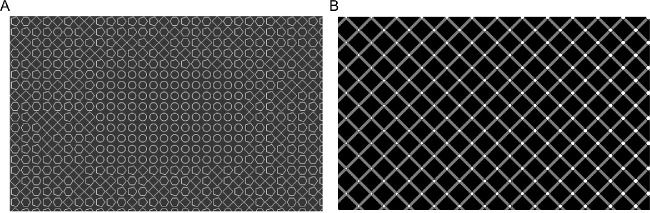
Visual illusions cancelling or inducing differences between foveal and peripheral appearance. (A) Uniformity illusion. Texture statistics are different in the central (only circles) and peripheral (squares, penta- and hexagons) part of the stimulus. After maintaining fixation on the centre for a few seconds, the peripheral part of the stimulus appears identical to the centre. Figure modified with permission from Otten, Pinto, Paffen, Seth, & Kanai (2017). (B) Extinction illusion. Each crossing of the grey bands contains a small white disk, but these disks are only visible in the fovea. Figure modified with permission from Ninio and Stevens (2000).